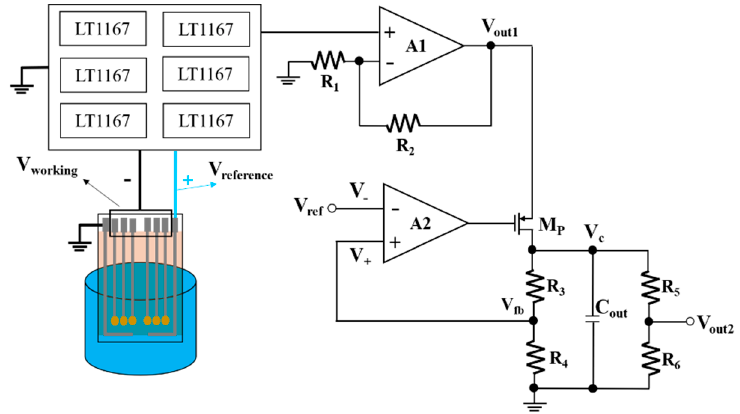
Figure 9. Circuit diagram of the calibration readout circuit for the drift effect [17].